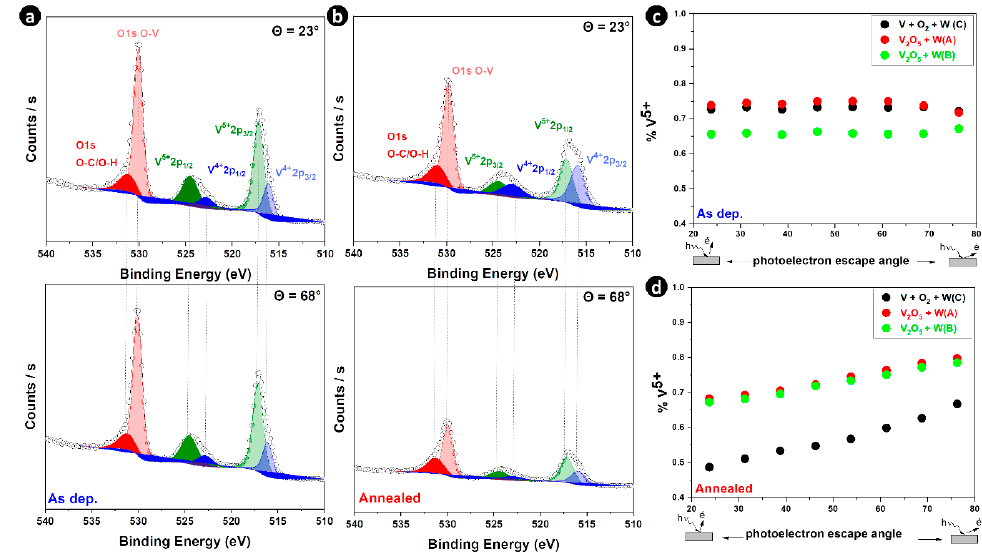
Figure 6. Fitted ARXPS spectra of V 2p and O 1s core-levels for sample C at detection angles of 23° and 68°, respectively, ( a ) before thermal annealing and ( b ) after thermal annealing. The concentration of the V 5+ oxidation state of vanadium was obtained from the fitted spectra of the V 2p electrons as a function of the angle of detection in all the samples, ( c ) before thermal annealing and ( d ) after thermal annealing.